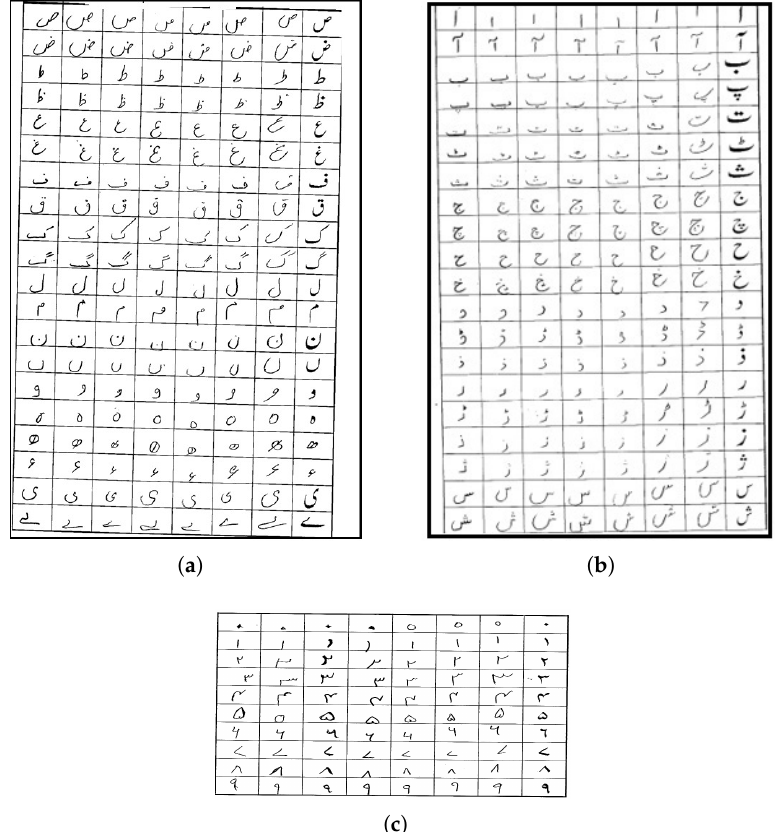
Figure 9. A sample of the handwritten Urdu characters is shown in ( a , b ), while ( c ) depicts a sample of handwritten Urdu numerals.